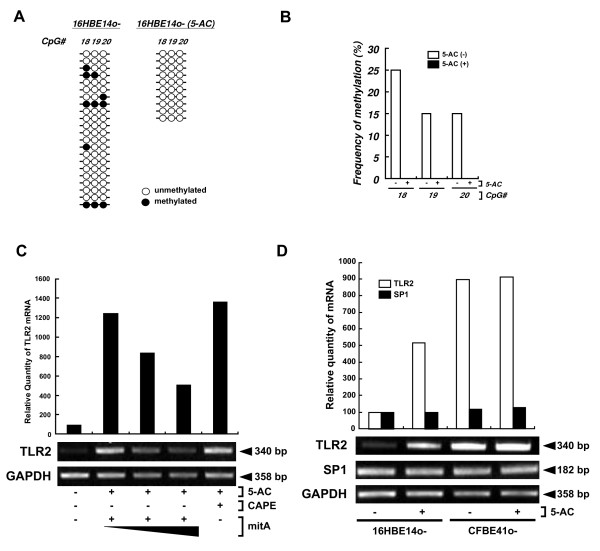
Assessment of the effect of SP1 hypomethylation on TLR2 expression. (A, B) 5-AC decreases CpG methylation adjacent to the SP1 binding site within human TLR2 promoter. Genomic DNA from 16HBE14o- cells was either treated with 5-AC for 7 days or untreated (n = 20 for 5-AC-untreated; n = 10 for 5-AC-treated) and then analyzed by sodium bisulfite sequencing. (A) Methylation profiles of the CpG sites (4, 5, 18, 19, 20) adjacent to the SP1 binding sites within TLR2 promoter. (B) The percent of methylated CpGs in each CpG site is shown. (C) Assessment of the effect of Mit A treatment in 5-AC-induced TLR2 up-regulation. 16HBE14o- cells were untreated or treated with 5-AC for 7 days, and then treated with mitA (0.1, 1 μM) for 24 hr or with 100 μM CAPE 3 hr. (D) SP1 expression after 5-AC treatment. 16HBE14o- and CFBE41o- cells were either treated with 5-AC for 7 days or untreated. Total RNA extracted from from both cell lines (in both (C) and (D)) and analyzed by semi-quantitative RT-PCR. TLR2 and SP1 expression was quantified by normalizing to GAPDH and assayed using Image Gauge. Results are representative of three independent experiments.